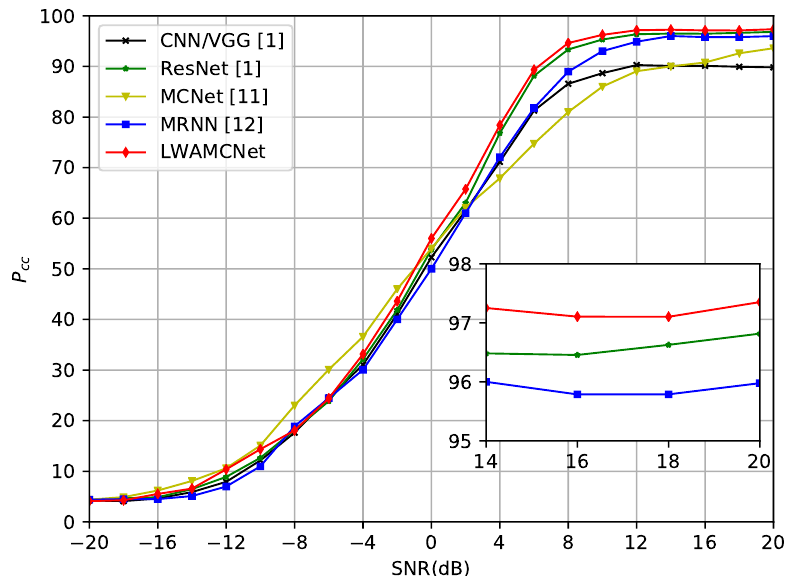
Figure 3. Correct classification probability of different networks on RadioML2018.01A